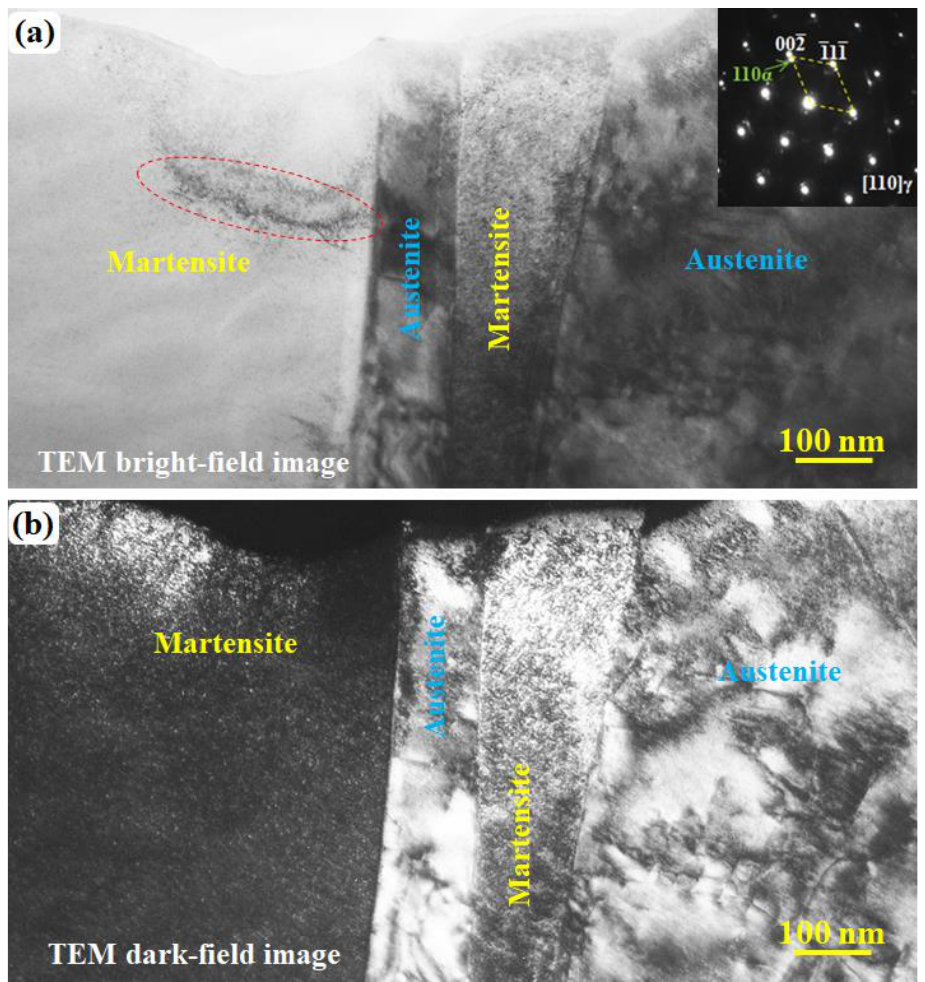
Figure 2. TEM bright field ( a ) and dark field ( b ) images revealing that the substructure in quenched martensite and retained austenite is different. The inset in ( a ) is the SAED pattern containing both austenite and martensite diffraction spots. The dark field image ( b ) was taken using the spots (00 2 ̅ ) γ and (110)α.